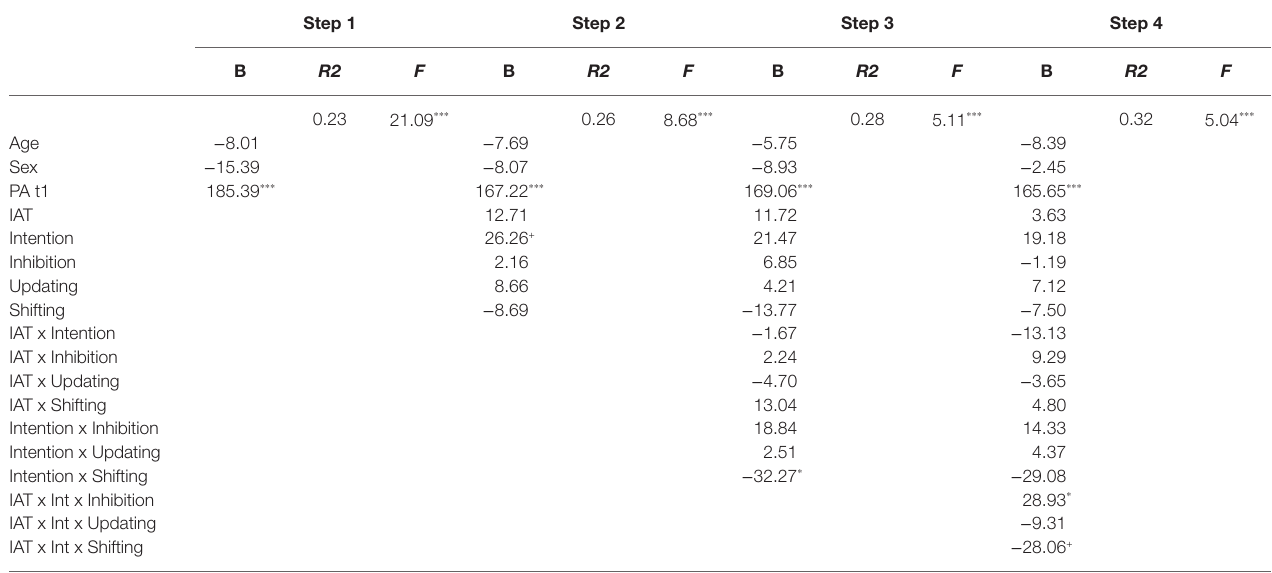
TABLE 2 | Hierarchical multiple regression analyses with IAT, intention, EFs and their interactions as predictors of PA at t2 (controlling for age, sex and PA (t1); n =